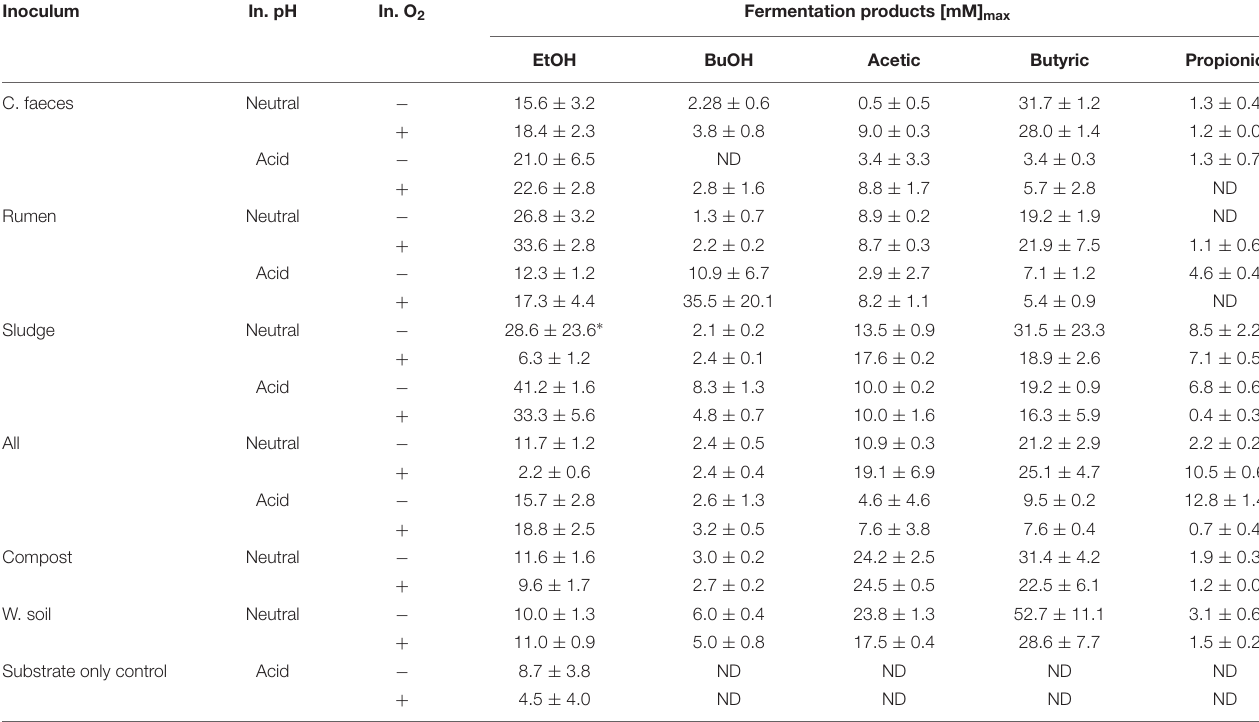
TABLE 1 | Maximal concentrations of measured fermentation products by each inocula tested. Inoculum In. pH In. O 2 Fermentation products [mM] max EtOH BuOH